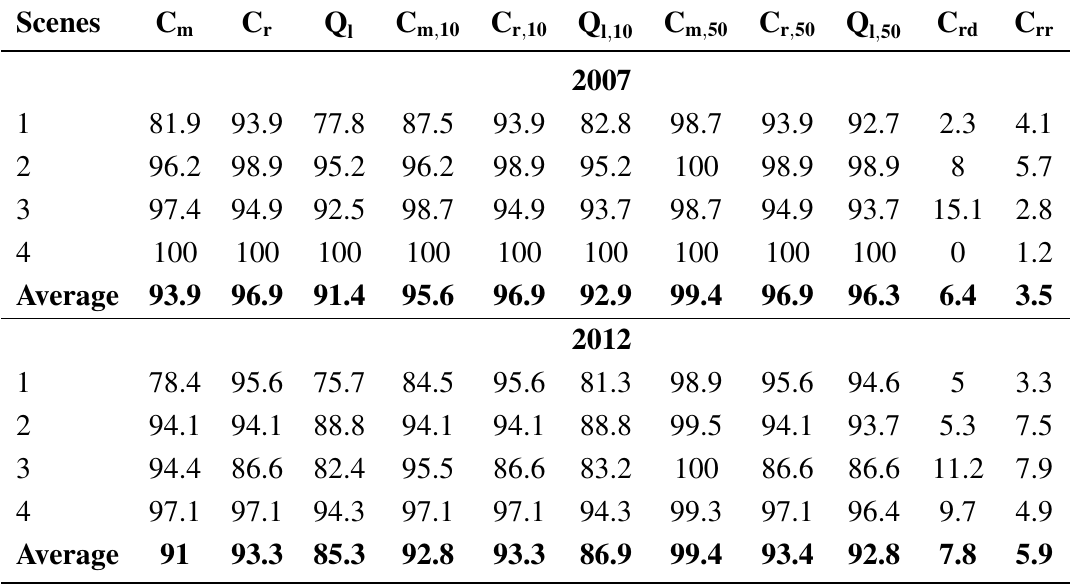
Table 3. Object-based building detection results. C Q = quality ( C l 50 m 2 , respectively), C cross-lap (over-segmentation) rates are in percentages.